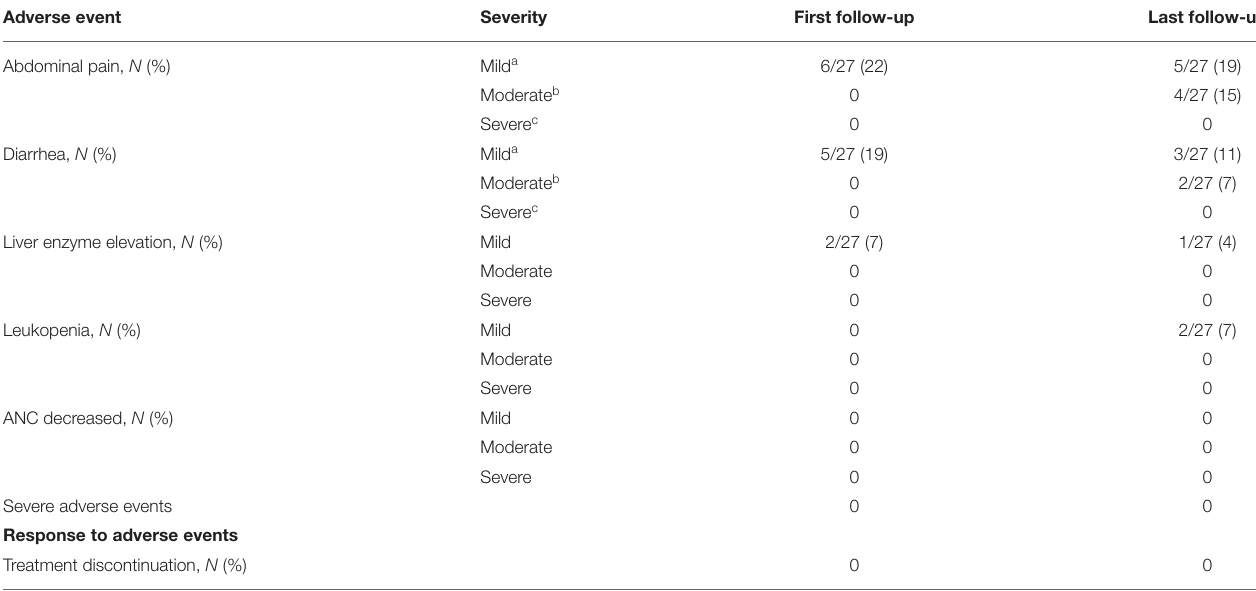
TABLE 3 | Colchicine safety: adverse events of 27 PFAPA patients. Adverse event Severity First follow-up Last follow-up Abdominal pain, N (%) Mild a 6/27 (22) Moderate b Severe c Diarrhea, N